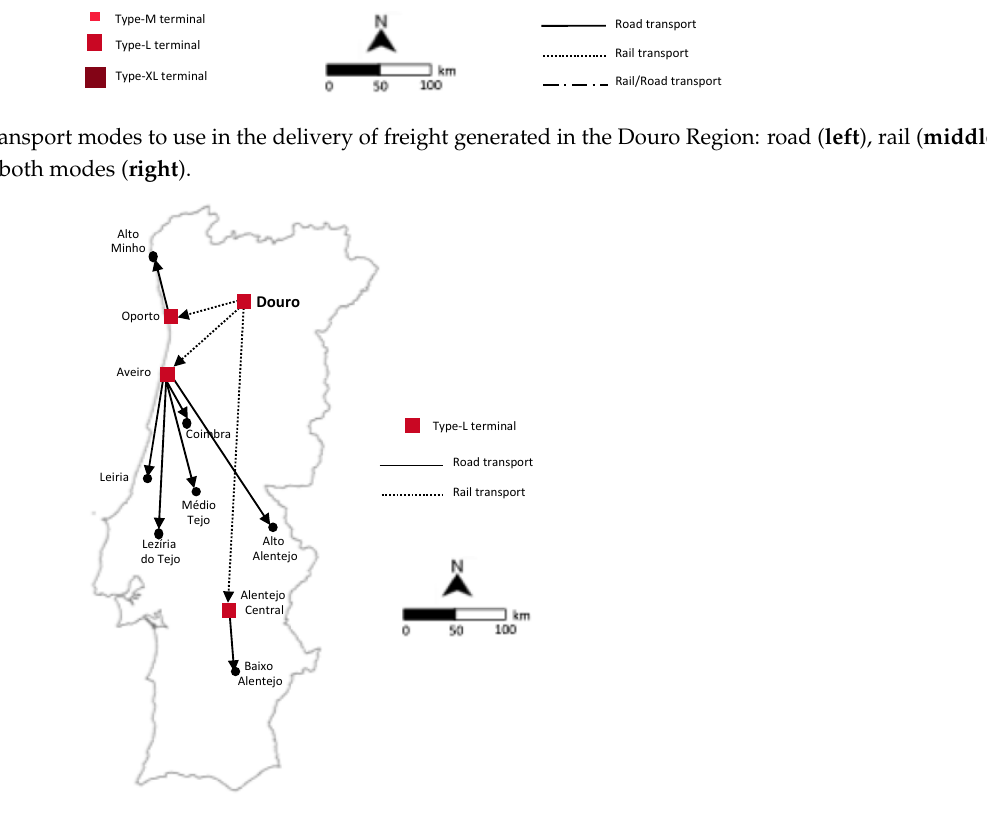
Figure 10. Optimal routes to deliver freight generated in the Douro Region when both rail and road are used as transport modes.